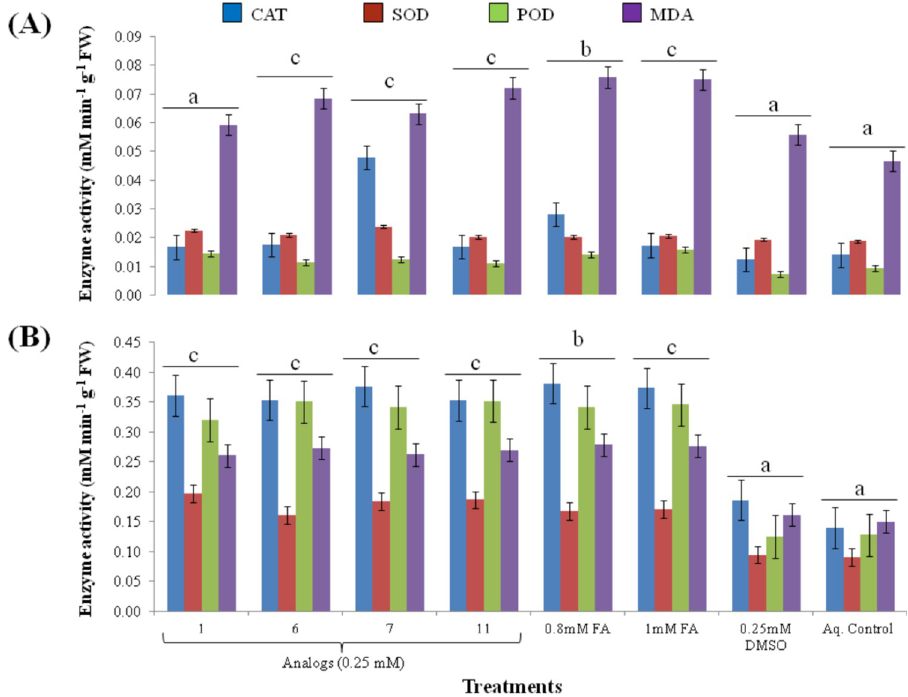
Fig 9. Levels of antioxidant enzymes (CAT, SOD, POD) and lipid peroxidation (MDA) in response 0.25 mM analogs, 0.8 and 1 mM ferulic acid (FA), 0.25 mM DMSO and aqueous control. (A) effect on Sinapis arvensis ; (B) effect on Lolium multiflorum . Analogs induced significant elevation of enzymes and lipid peroxidation similar to 1 mM FA. Values are presented as mean ± SE (n = 3). Bar values with different letters differ significantly from each other at P <